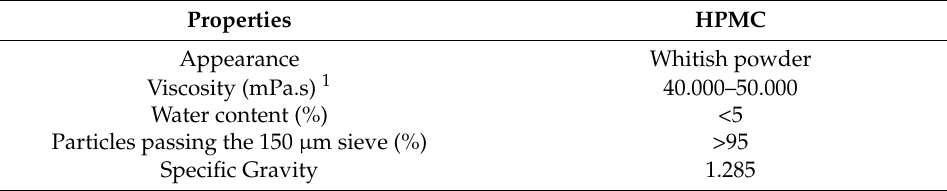
Table 2. Physical properties of HPMC.